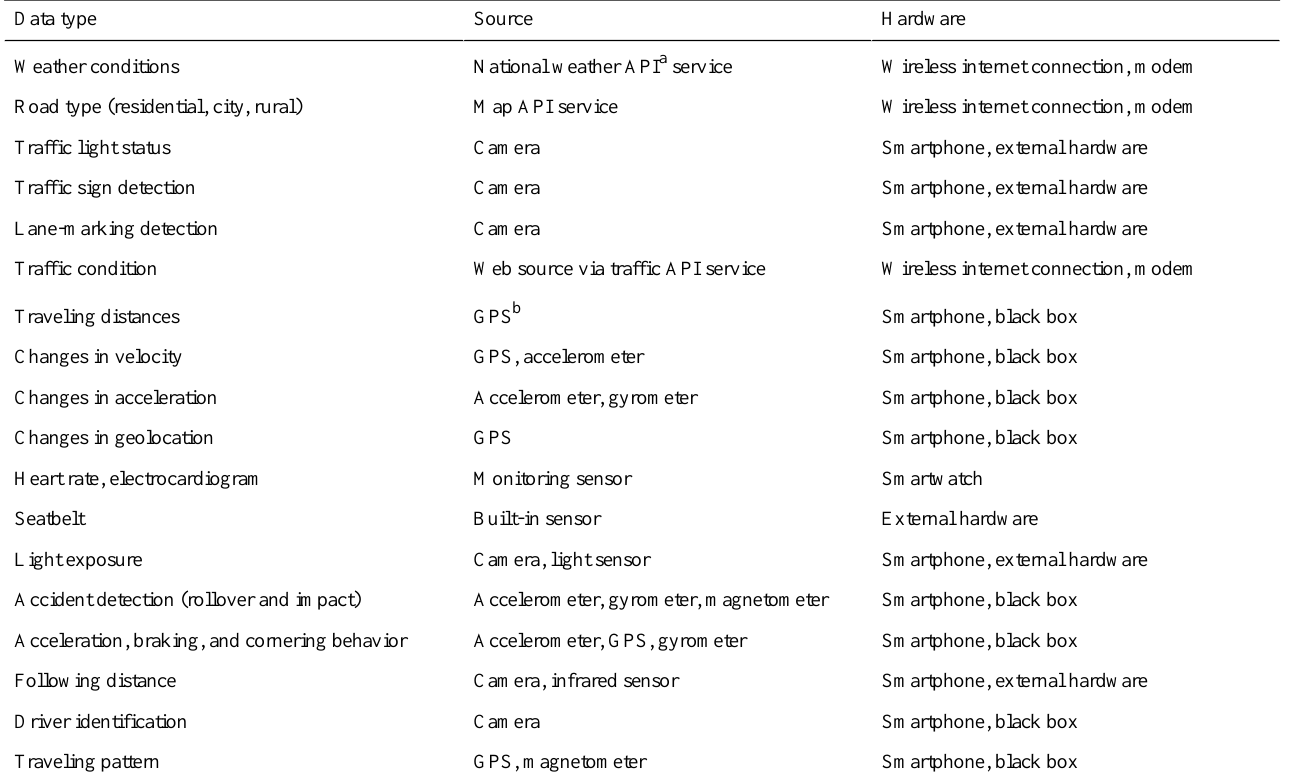
Table 1. Information collection and required hardware for in-vehicle